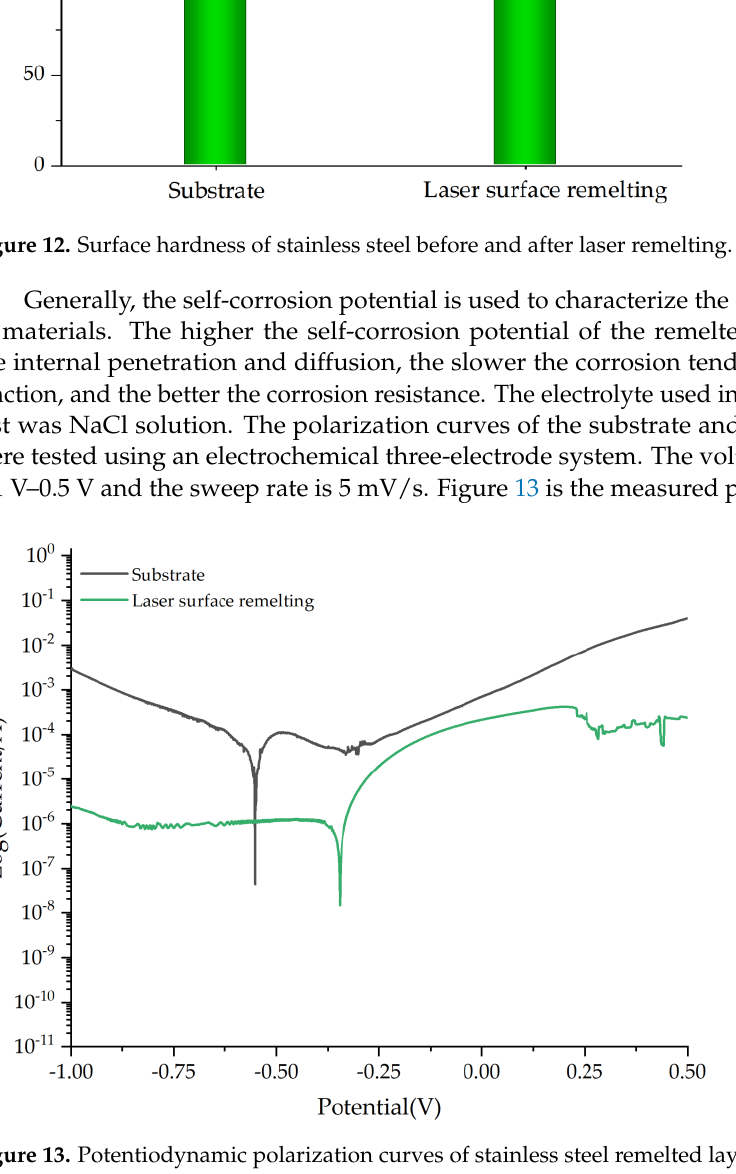
Figure 13. Potentiodynamic polarization curves of stainless steel remelted layer.